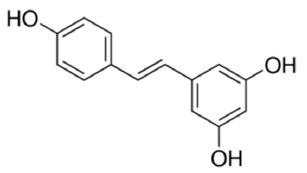
Figure 1. The structure of resveratrol.